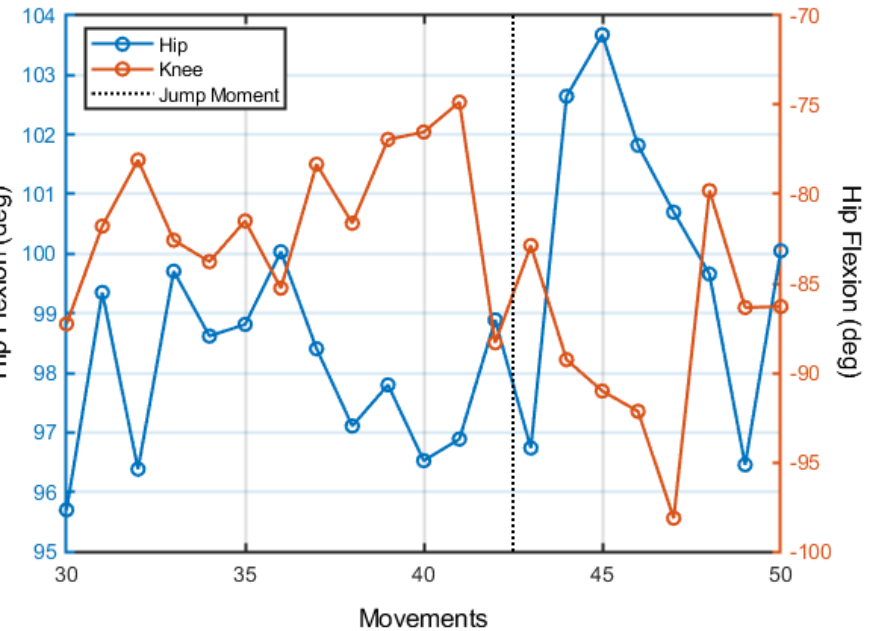
Figure 6. Trial-to-trial dynamics in terms of the hip and knee flexion position (at foot peak height) of participant 4. The black dashed line shows an instance of jump (discontinuous change in the trial-to-trial mean).